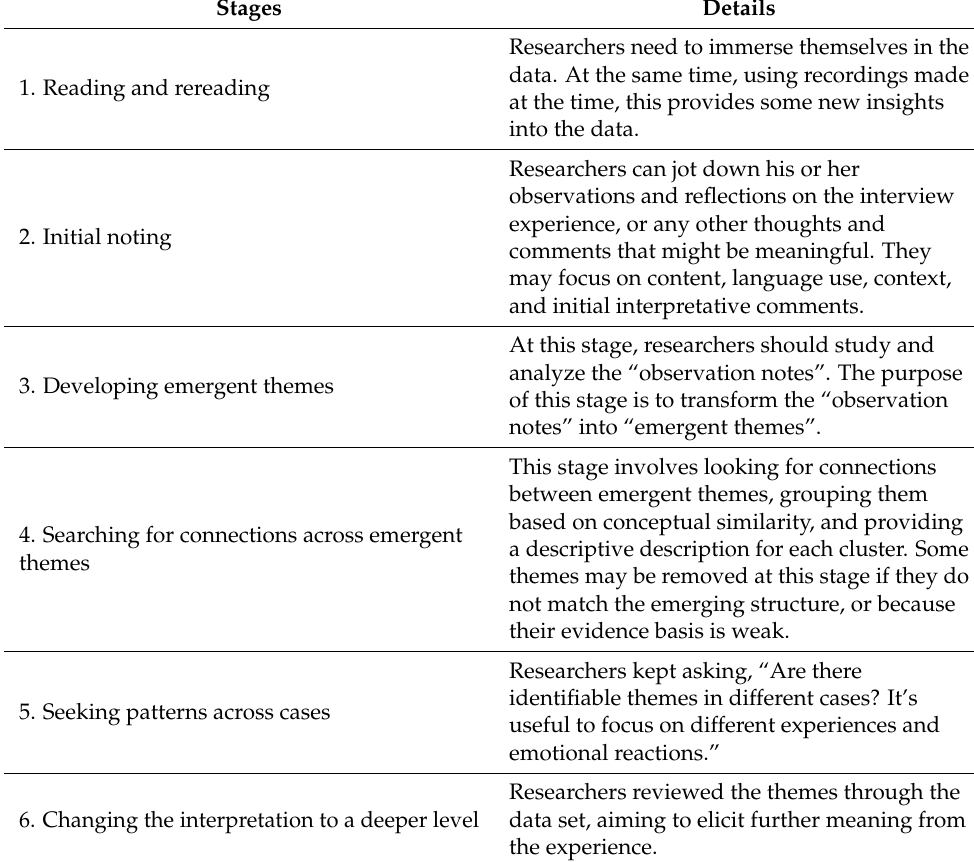
Table 2. Interpretative Phenomenological Analysis